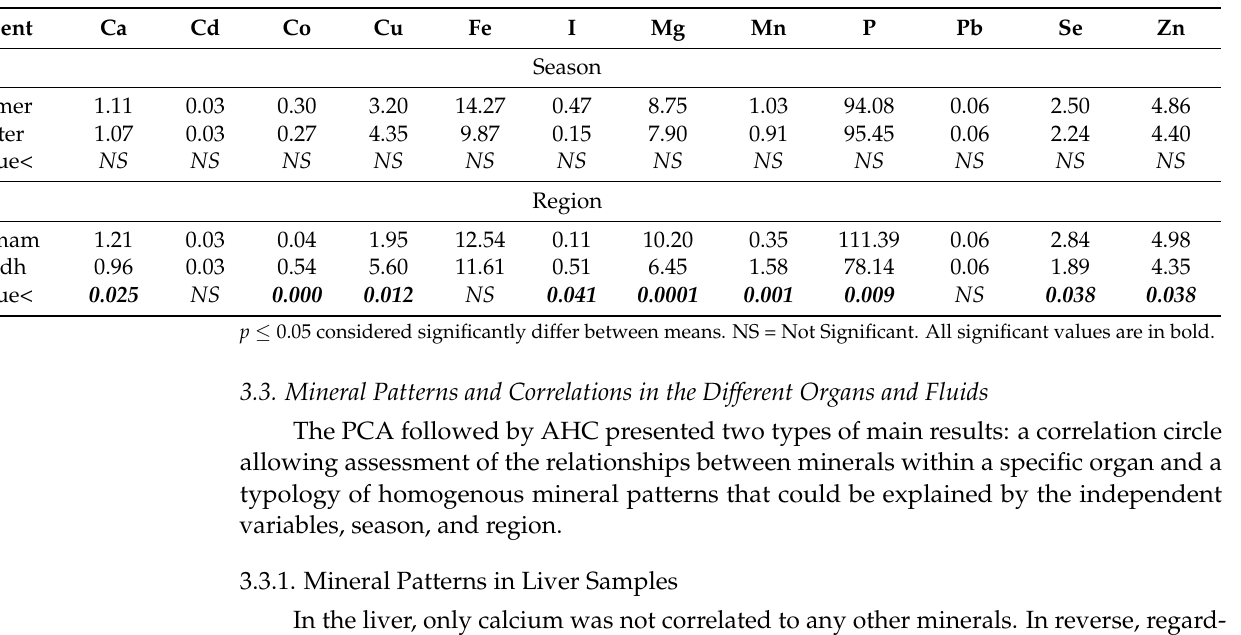
Table 9. Mean values of minerals in camel whole blood according to region and season [in µ